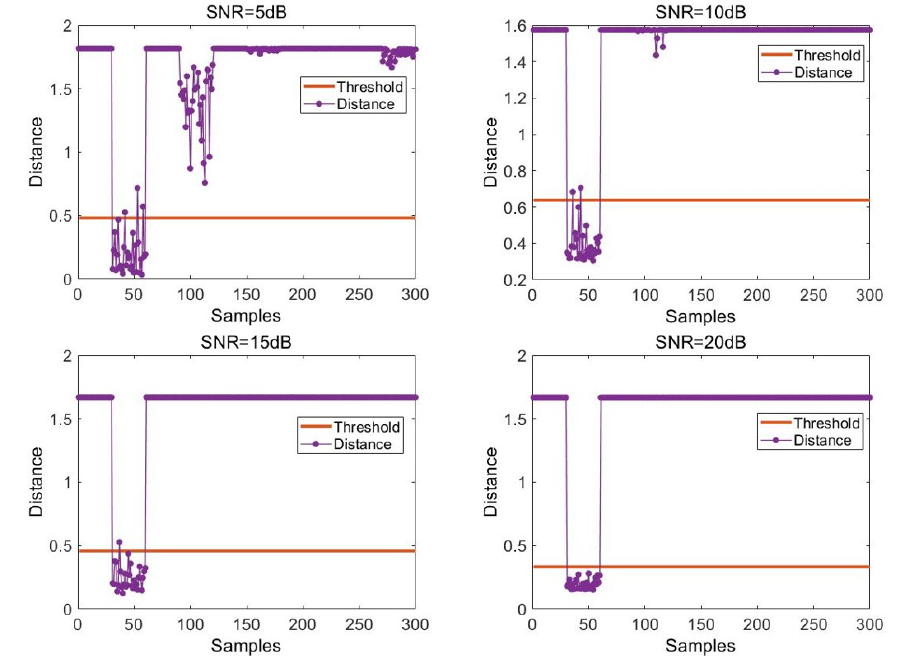
Figure 5. Schematic diagram of the distance between the sample point and the hypersphere. Signal-to-noise ratio